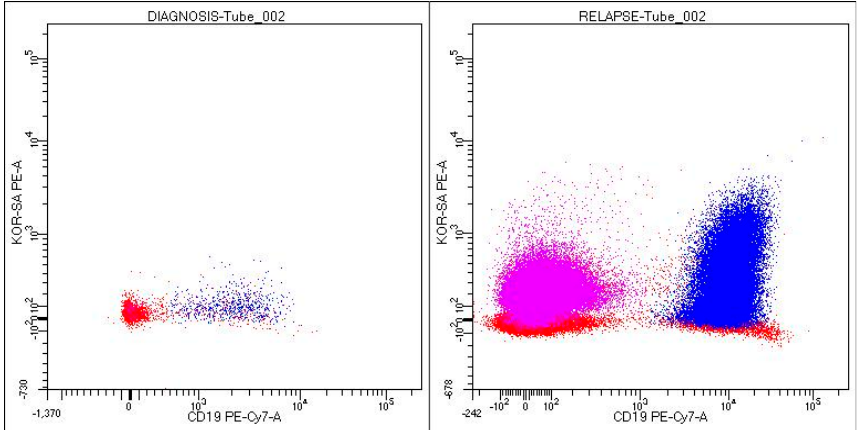
Figure 2. Immunophenotypic expression of KOR-SA at diagnosis versus relapse. In blue: CD19+ blasts (and CD34+). In violet: granulocytes as internal control (almost absent at diagnosis due to the hypocellular marrow sample and consequently few events).